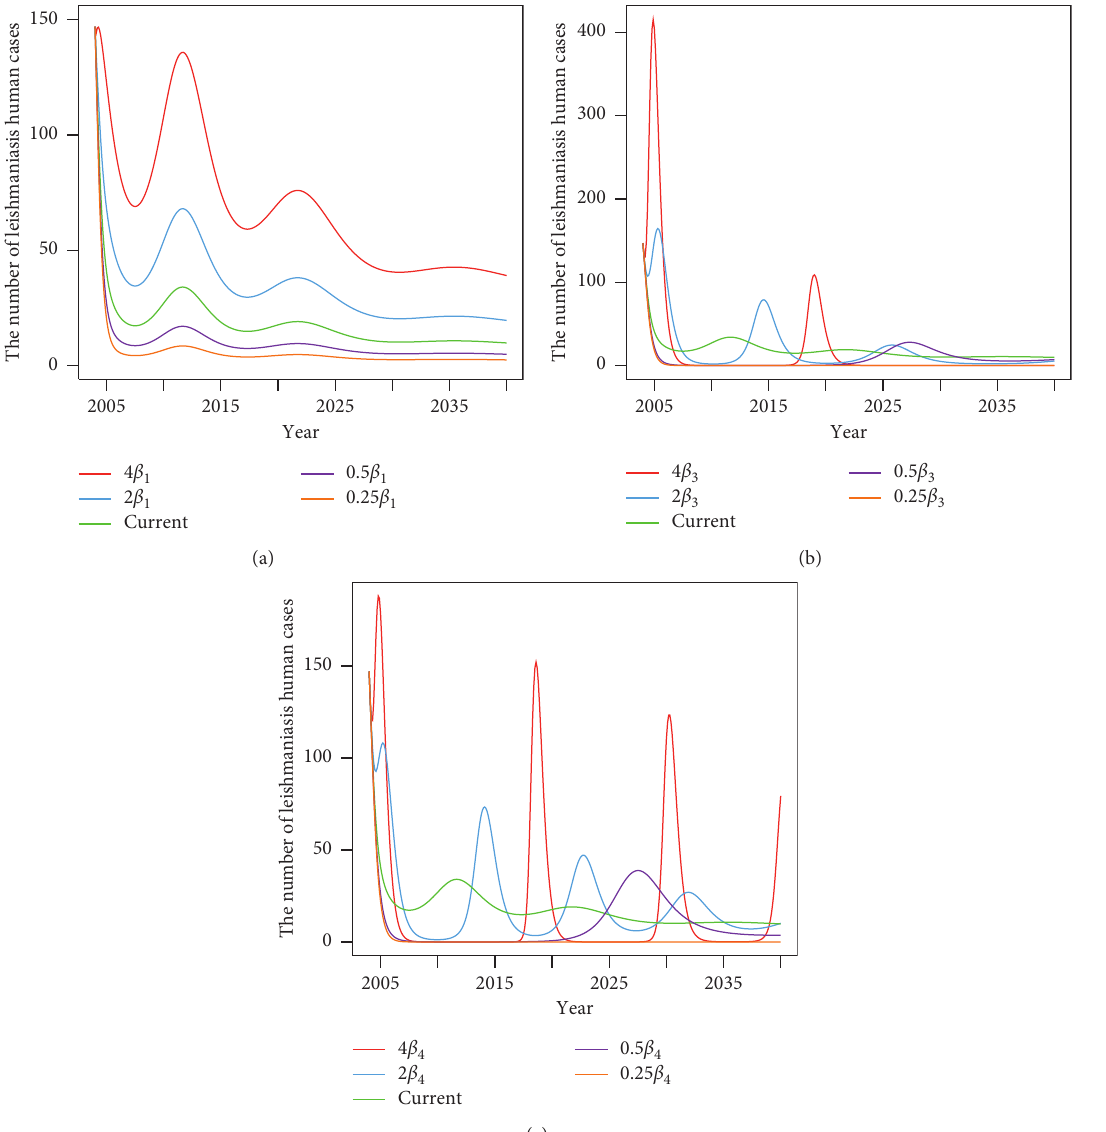
Figure 7: The influence of different values of parameters on the number of diseases of VL. (a) Versus β